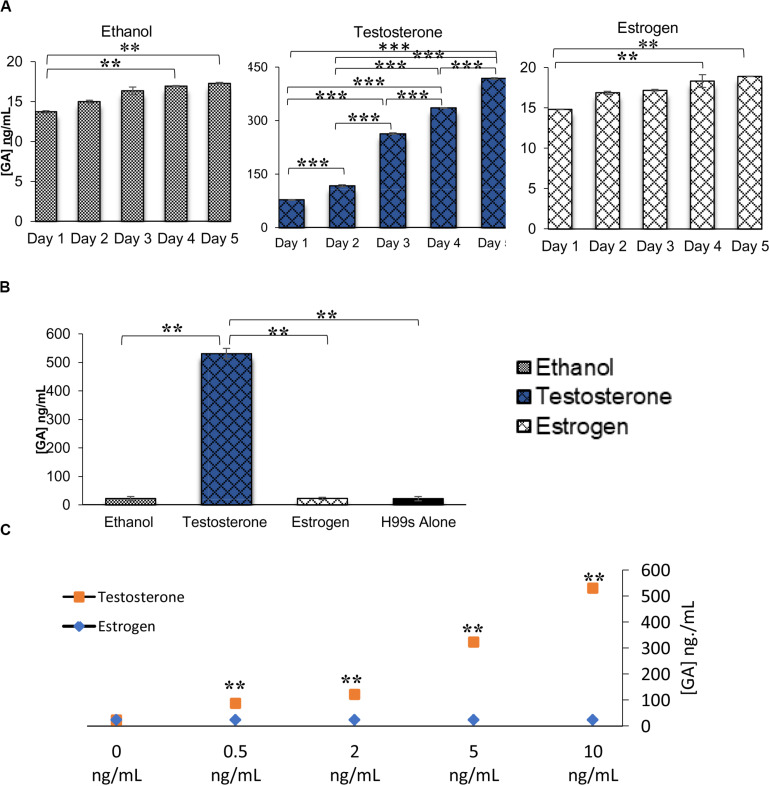
Gibberellic acid (GA) concentrations secreted from C. neoformans in various conditions measured via ELISA. (A) GA concentrations secreted from C. neoformans grown in steroid hormone-supplemented L-DOPA medium for 5 days. Error bars represent the standard deviation. Data is representative of three independent experiments. Statistical significance is represented as follows: in Ethanol treatment **p = 0.0167 comparing Day 1 and Day 4 and **p = 0.0089 comparing Day 1 to Day 5, in Testosterone treatment all days are different ***p < 0.001, in Estrogen treatment **p = 0.01 comparing Day 1 and Day 4 and **p = 0.0037 comparing Day 1 to Day 5, using MANOVA with simple contrasts. (B) GA concentrations secreted from C. neoformans grown in steroid hormone-supplemented conditioned medium at the 32 h time point. Error bars represent the standard deviation. Data is representative of three independent experiments. Statistical significance is represented as follows: **p < 0.001 using Tukey–Kramer HSD. (C) GA concentrations secreted from C. neoformans while grown in various concentrations of testosterone or estrogen (estradiol). The X-axis depicts the concentrations of testosterone. Error bars represent the standard deviation. Data is representative of two independent experiments. **p < 0.001, using MANOVA with simple contrasts.